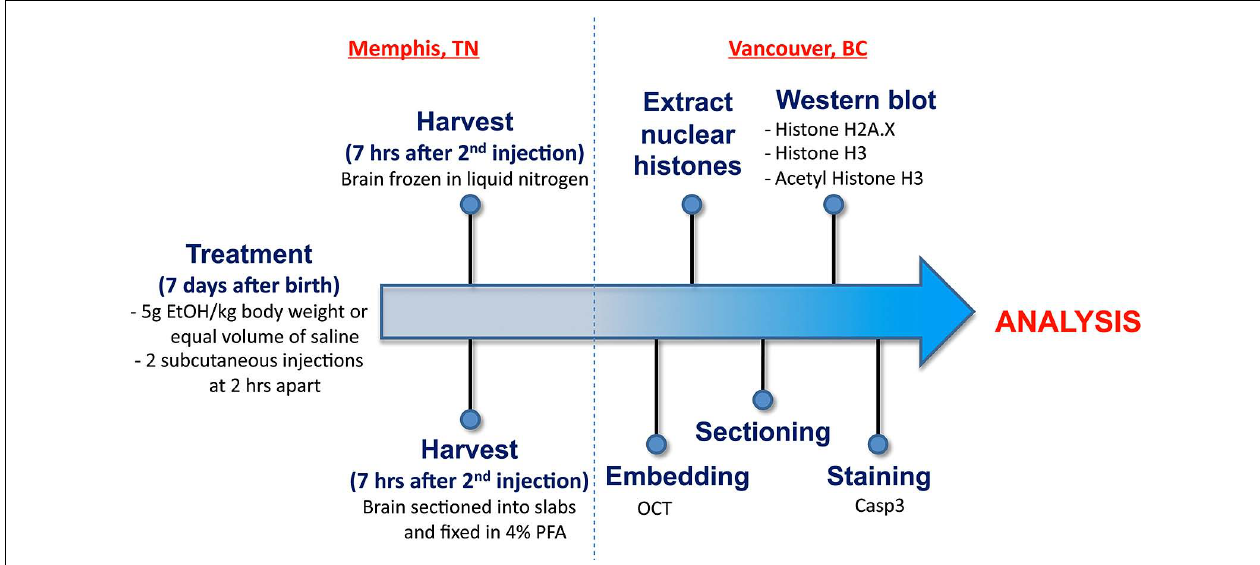
FIGURE 1 |An overview of the workflow from generation of postnatal mice through to staining and analysis.